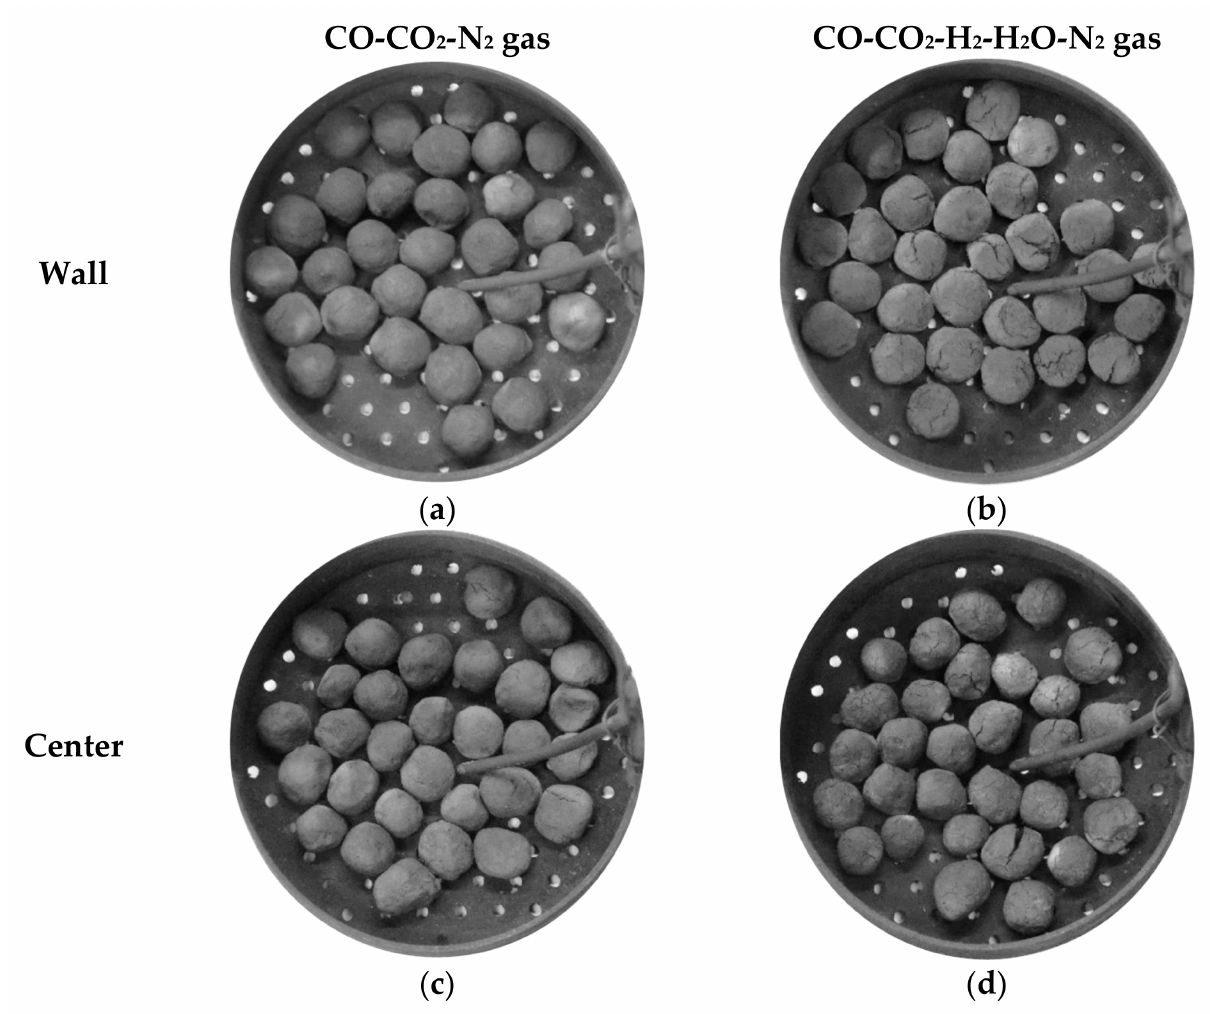
Figure 11. Pellets photographed in the sample basket after the non-isothermal reduction, using ( a ) the wall profile in CO-CO 2 -N 2 gas, ( b ) the wall profile in CO-CO 2 -H 2 -H 2 O-N 2 gas, ( c ) the center profile in CO-CO 2 -N 2 gas, and ( d ) the center profile in CO-CO 2 -H 2 -H 2 O-N 2